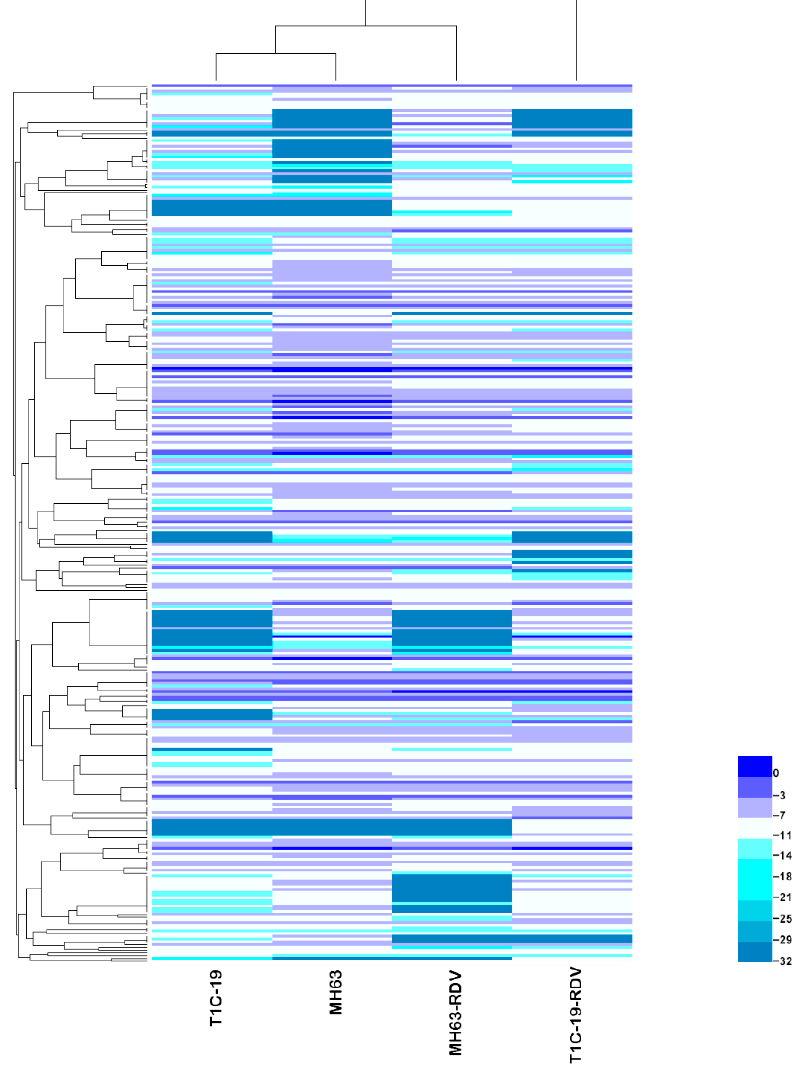
Figure 2. Hierarchical cluster analysis of the 320 identified metabolites in rice leaves of the four treatments. In the heatmap, each treatment is visualized in a single column, and each metabolite is represented by a single row. Metabolite accumulation is shown in different colors, where blue indicates high abundance and low relative expression is shown in indigo (color key scale on the right of the heat map).